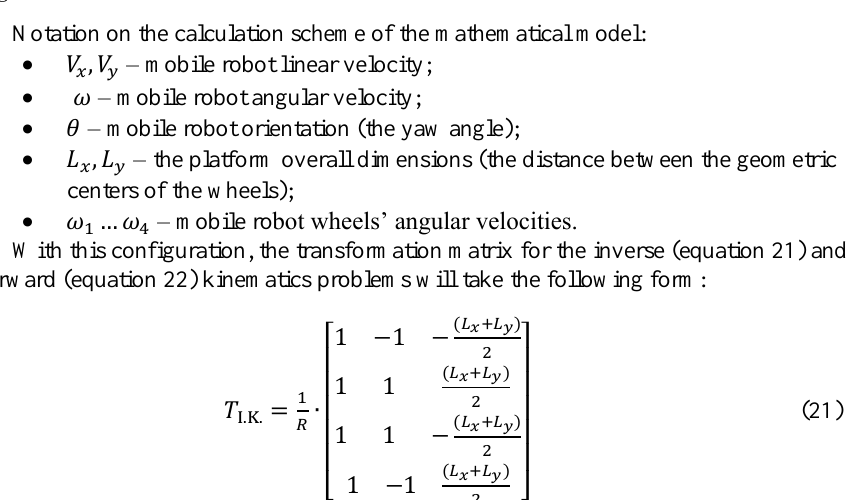
Fig. 10 . Calculation scheme of the mathematical model